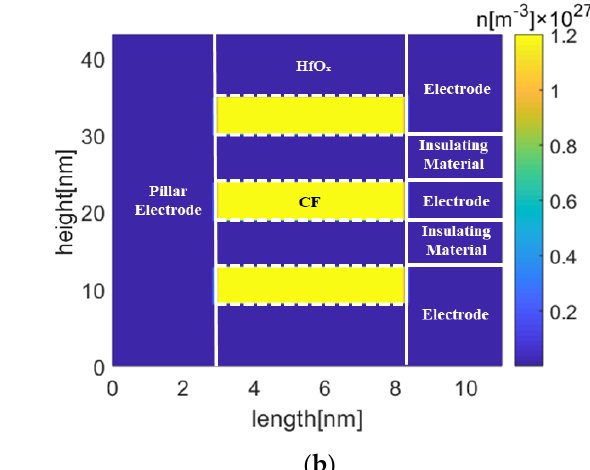
Figure 6. Distributions of ( a ) oxygen vacancy density and ( b ) temperature in Pt-RRAM. Both top and bottom cells are active, and captured at 0.2 s.